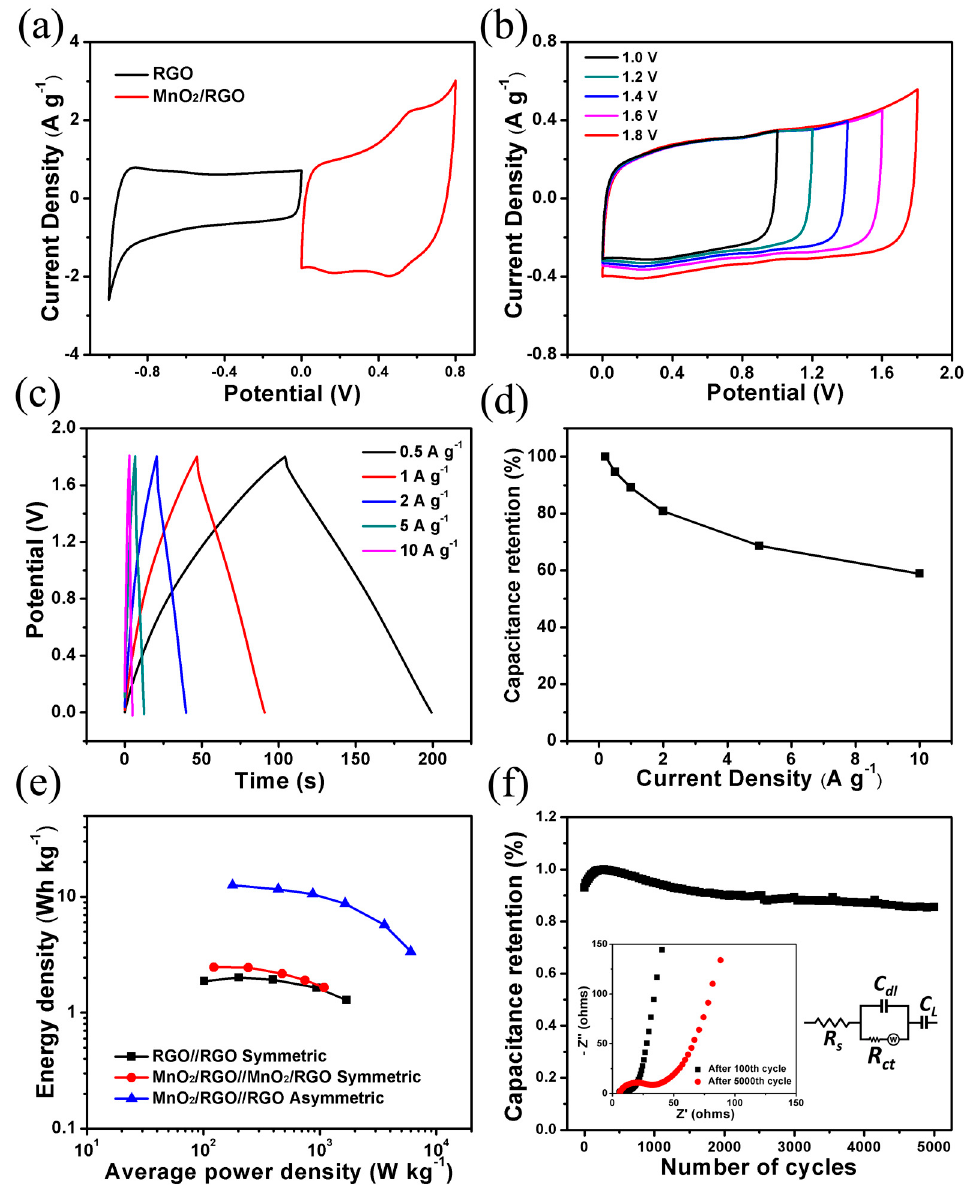
Figure 5. ( a ) Cyclic voltammetry (CV) curves of RGO and MnO 2 /RGO hydrogel films at a scan rate of 10 mV s − 1 collected in a three-electrode system with an Ag/AgCl reference in 1 M Na 2 SO 4 . Electrochemical performance of the assembled flexible asymmetric SC of MnO 2 /RGO//RGO: ( b ) CV curves at a scan rate of 10 mV s − 1 with a different potential window; ( c ) Galvanostatic charge–discharge curves at various current densities from 0.5 A g − 1 to 10 A g − 1 ; ( d ) Capacitance retention as a function of discharge currents. ( e ) Ragone plots of the asymmetric device of MnO 2 /RGO//RGO (1.8 V), the symmetric device of RGO//RGO (1 V), and MnO 2 /RGO//MnO 2 /RGO (0.8 V). ( f ) Cycling stability of MnO 2 /RGO//RGO at a current density of 1 A g − 1 (the inset image shows Nyquist plots before and after 5000 cycles, and the electrical equivalent circuit used for fitting impedance spectra).